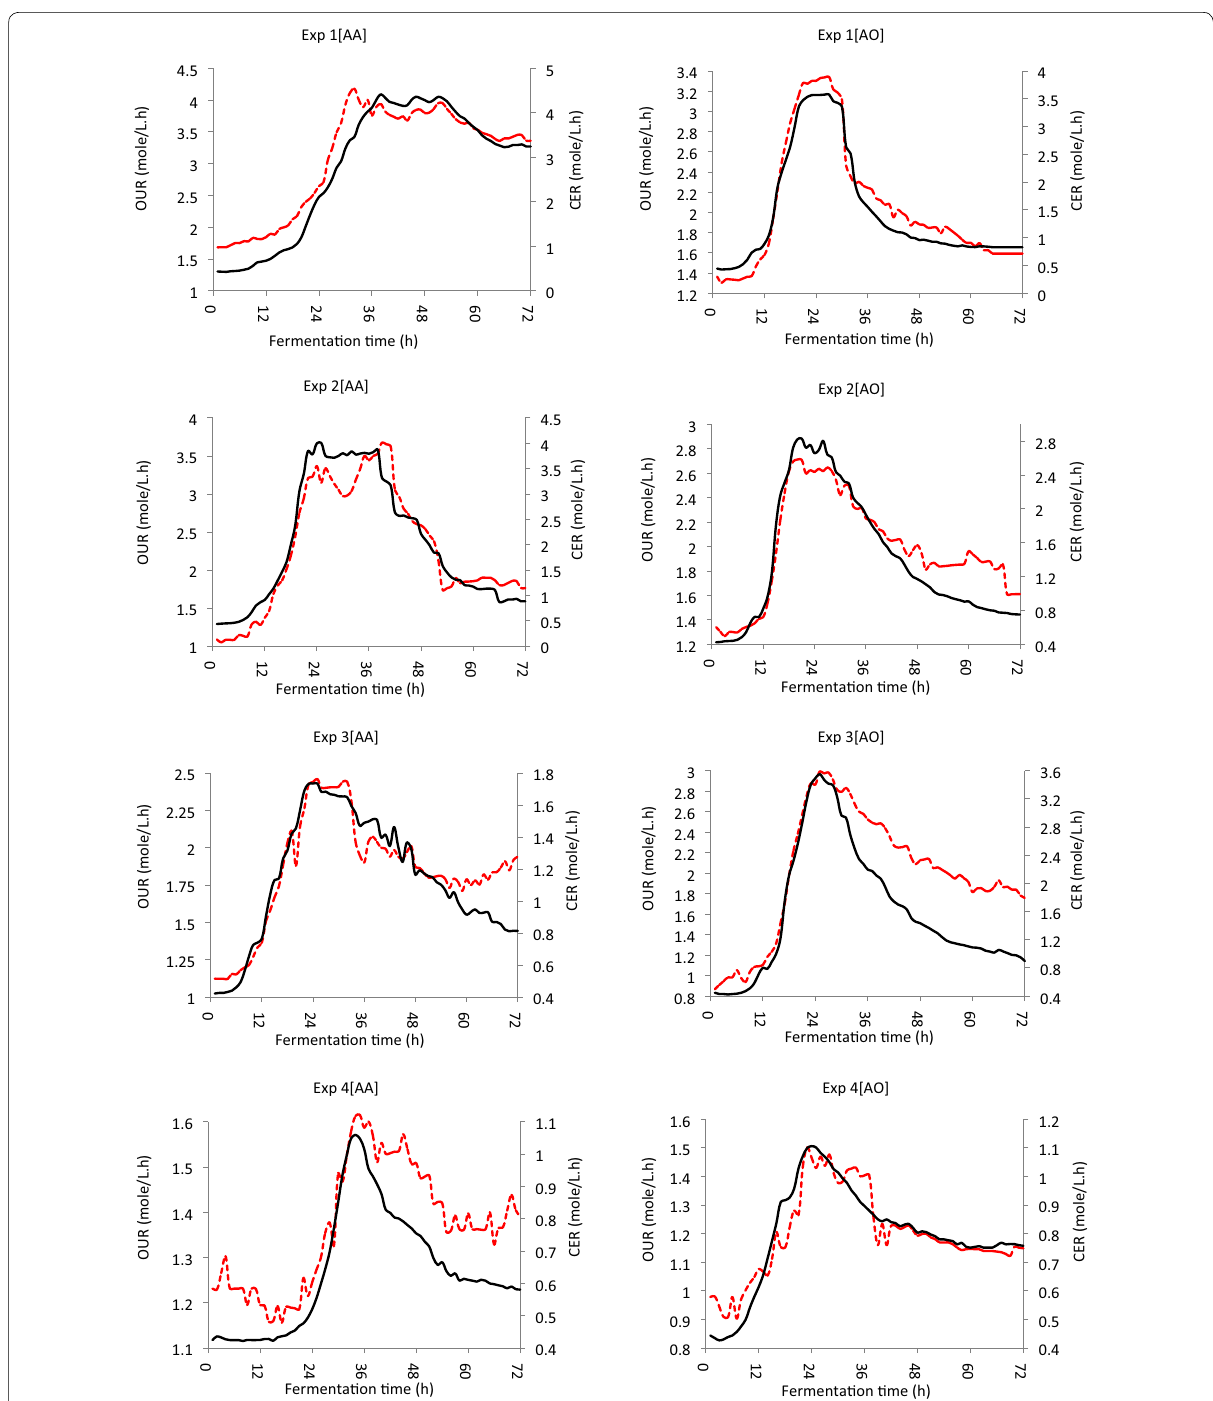
Fig. 6 Indirect fungal growth of multi-stacked tray solid-state bioreactor using four strategies of initial moisture content with respect to oxygen uptake rate [OUR: red lines] and carbon dioxide evolution rate [CER: black lines] with A. awamori [AA] and A. oryzae